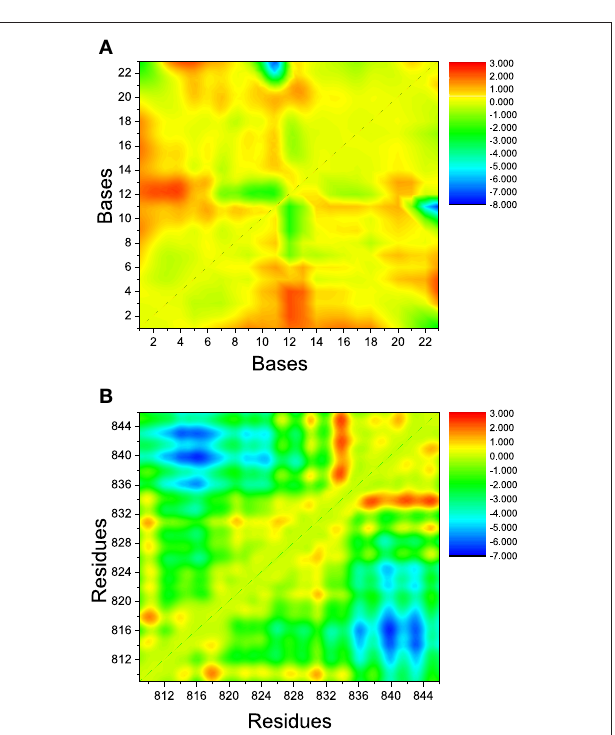
FIGURE 6 | The landscape of distance difference between bound and apo states. (A) DNA/RNA, (B) polymerase. The color in red represents positive distance difference. The color in blue represents negative distance